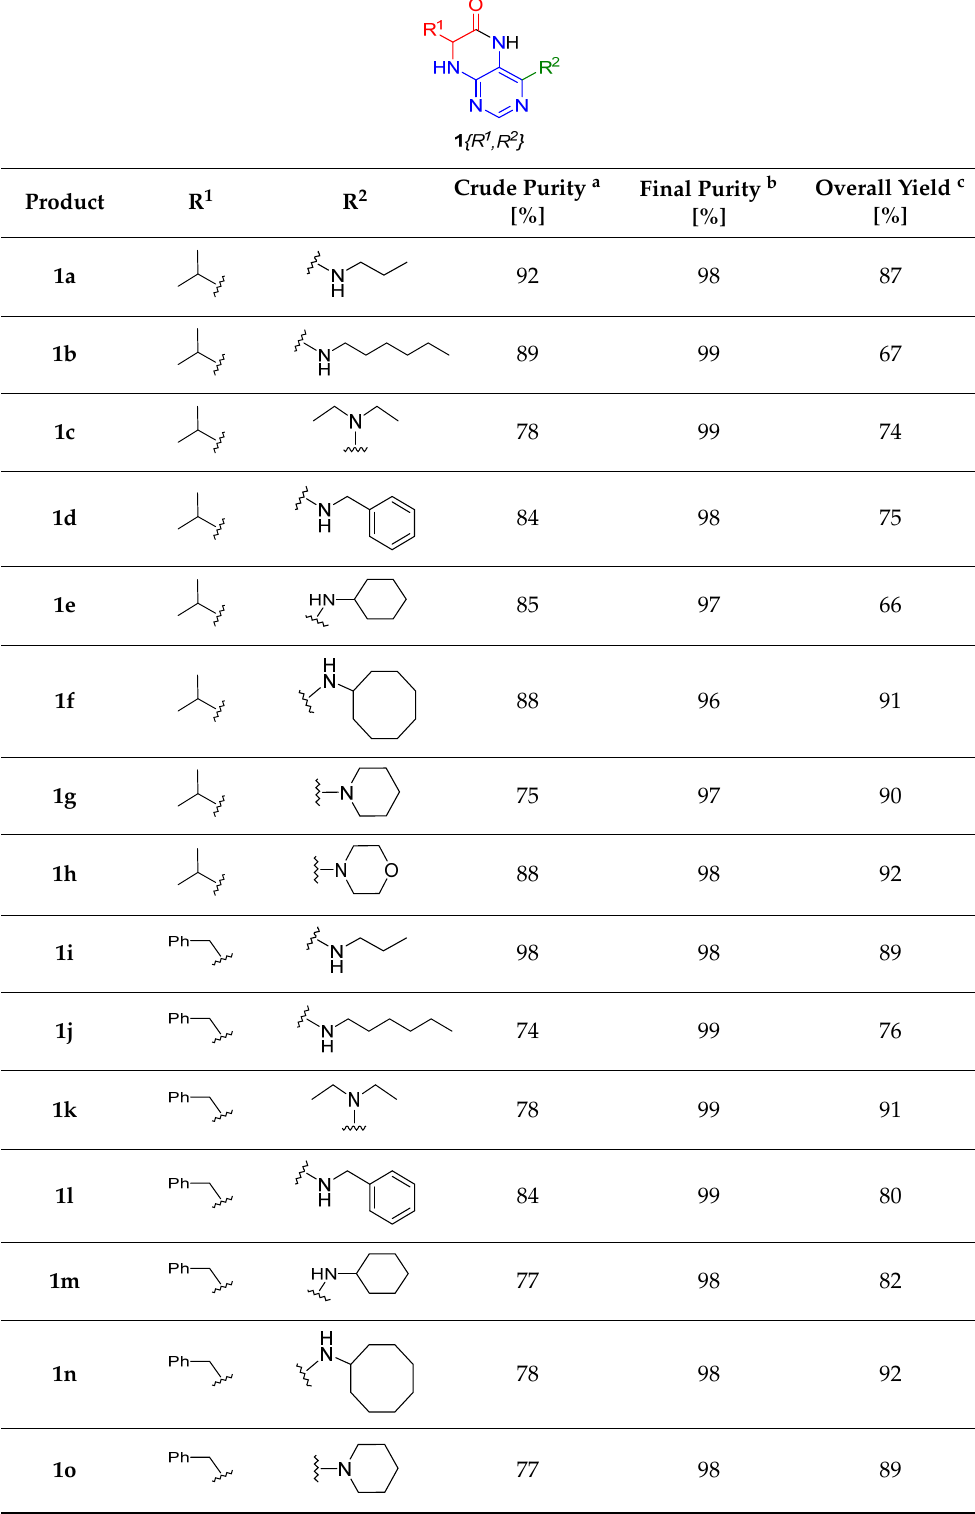
Table 1. Overview of synthesized dihydropteridinones 1 .